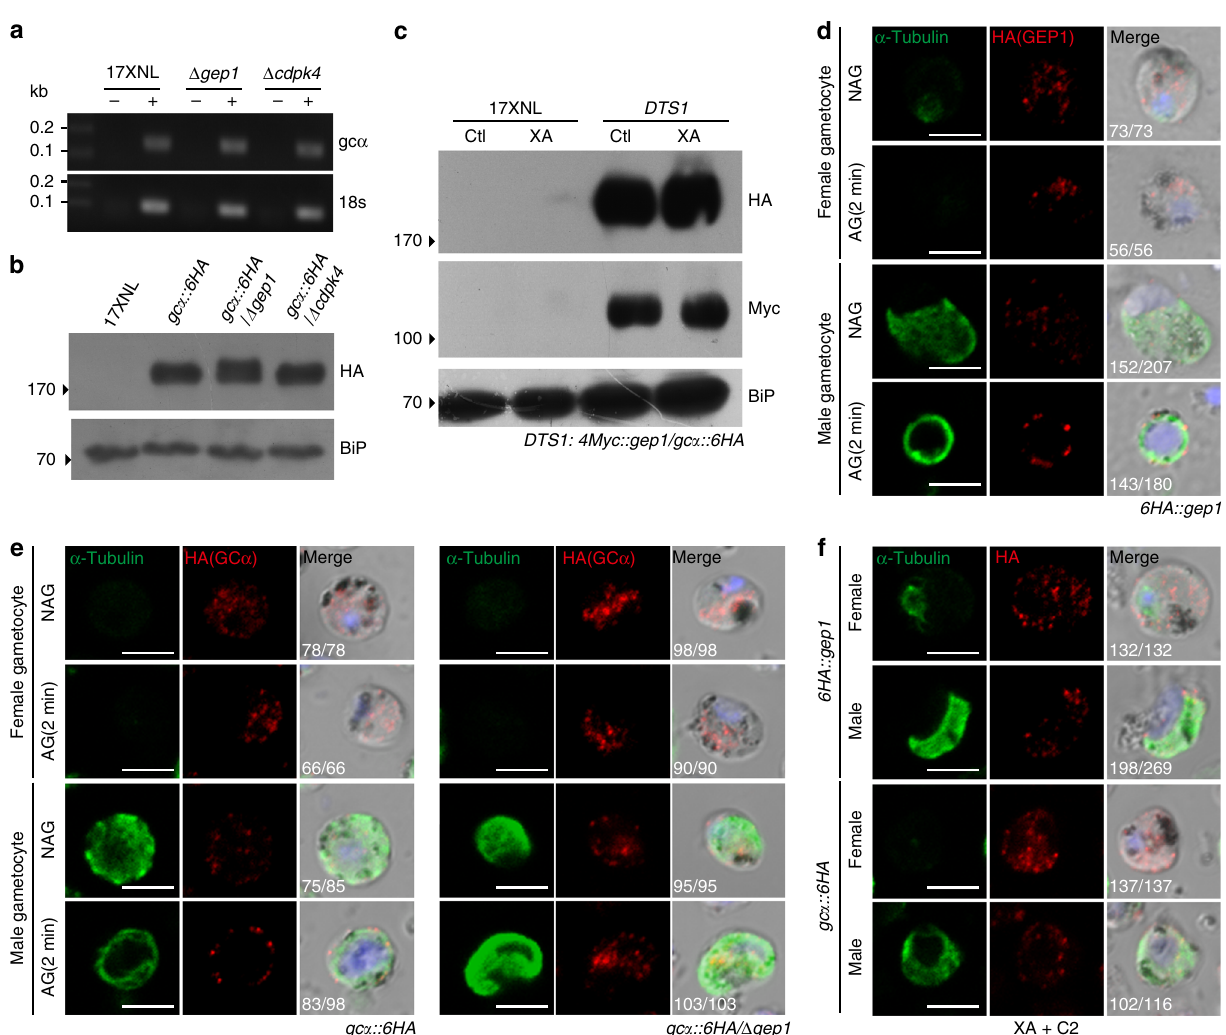
Fig. 7 GC α expression and localization in the GEP1-depleted gametocytes. a RT-PCR analysis of gc α transcript in gametocytes of the 17XNL, Δ gep1 , and Δ cdpk4 parasites. b Western blotting detecting GC α protein in gametocytes of the 17XNL, gc α ::6HA, gc α ::6HA/ Δ gep1 , and gc α ::6HA/ Δ cdpk4 parasites. c Western blotting detecting GEP1 (Myc) and GC α (HA) proteins expression in gametocytes of DTS1 parasite 2 min post XA stimulation. Ctl are control groups without XA stimulation. d Co-staining of GEP1 and α -Tubulin expressions in gametocytes of the 6HA::gep1 parasite 2 min post XA stimulation. NAG: non-activated, AG: XA stimulation. e Co-staining of GC α and α -Tubulin expressions in the gc α ::6HA and 6HA::gc α / Δ gep1 gametocytes 2 min post XA stimulation. NAG: non-activated, AG: XA stimulation. f Co-staining of α -Tubulin and HA-tagged GEP1 or GC α expressions in the 6HA::gep1 (upper panel) and gc α ::6HA (lower panel) gametocytes 2 min post XA stimulation plus C2 treatment. x / y in d , e , and f are the number of cell displaying representative signal/the number of cell analyzed. Scale bar = 5 μ m for all images in this fi gure. All experiments in this fi gure were repeated three times